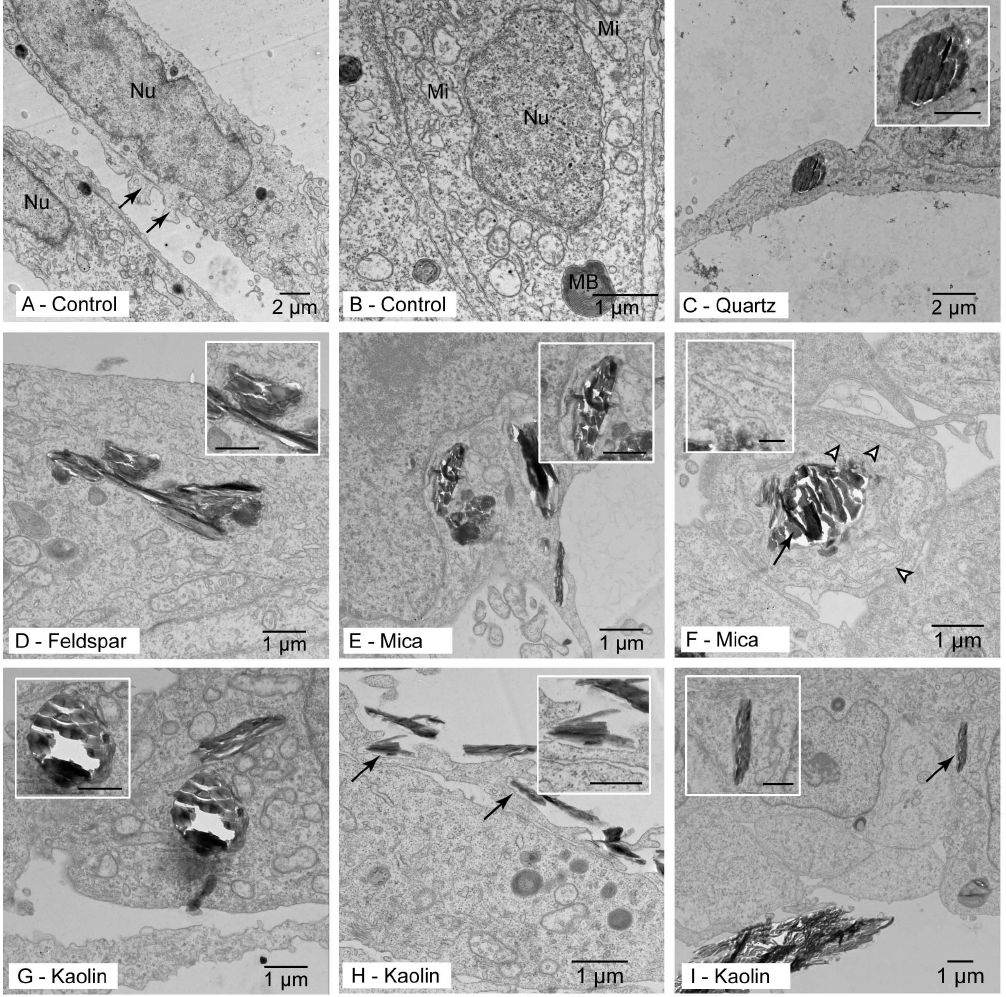
Figure 1. Control cells as well as particle uptake and effects. Pictures were taken after 72 h exposure either without (control) or with 250 mg L 2 1 of the respective particle. Shown are examples for A.) Control cells, with marked nucleus (Nu) and arrows pointing to rudimentary microridges. B.) Control cell detail, with nucleus (Nu), mitochondria (Mi) and a myelin body (MB). C.) Quartz particle, phagocytized. D.) Feldspar particle, phagocytized. E.) Mica particle, phagocytized. F.) Mica particle, dilated endoplasmic reticulum. G.) Kaolin particle, phagocytized. H.) Kaolin particle phagocytosis (arrows, with inset showing detail of particle marked on the upper left). I.) Kaolin particle in cytoplasm without surrounding membrane. In all insets bar denotes 0.5 m m. Note: white areas around particles represent artifacts due to sectioning.